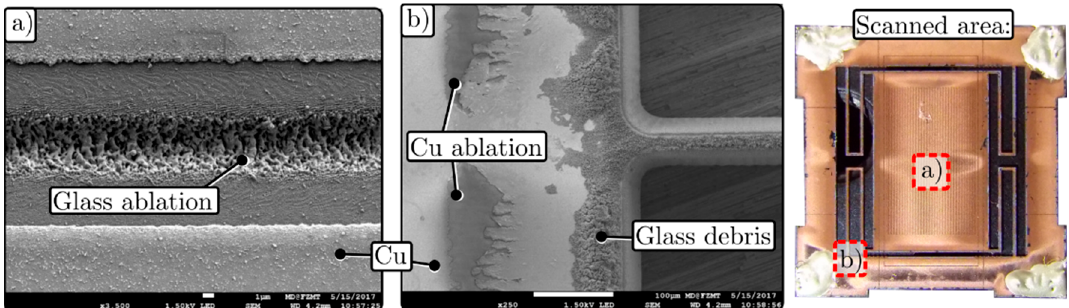
Figure 2. Detailed SEM photos taken after the transducer manufacturing process. The scanned area at the center of the mass ( a ) depicts glass ablation caused by too high laser energy. ( b ) Glass debris from the cutting process and Cu ablation as result of laser back